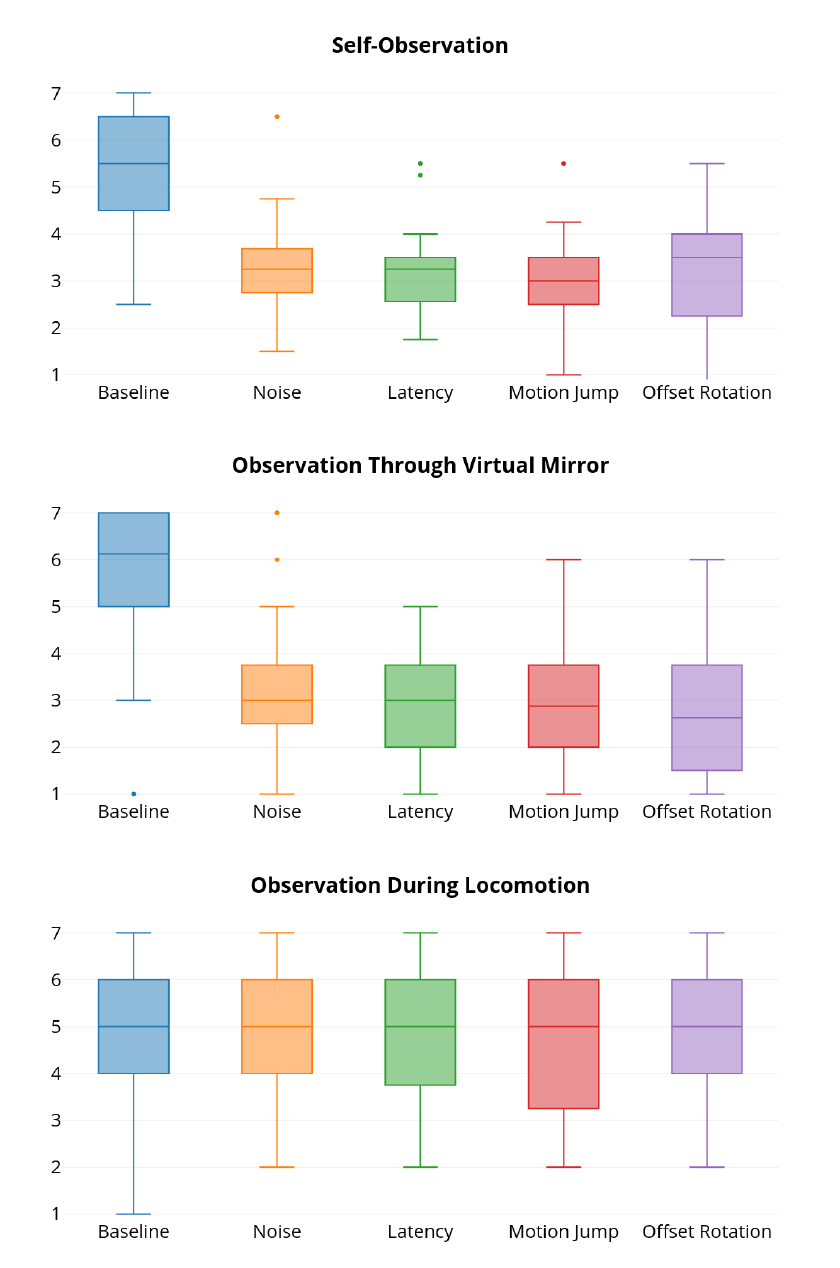
Figure 5. Participants’ responses to questions on self-agency for each task